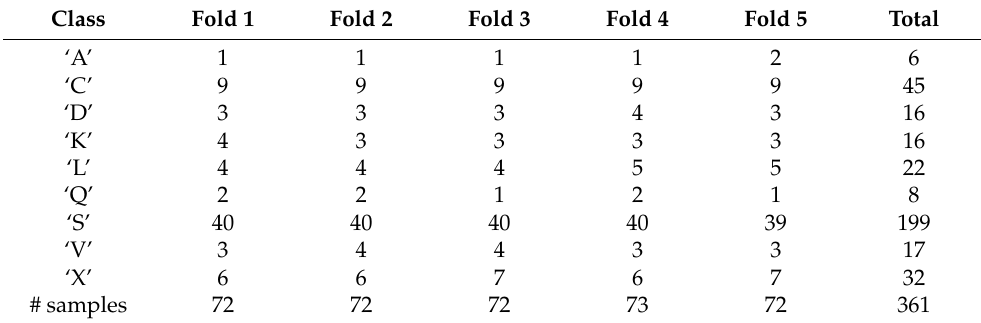
Table 4. Experimental data partition of 5-folds.